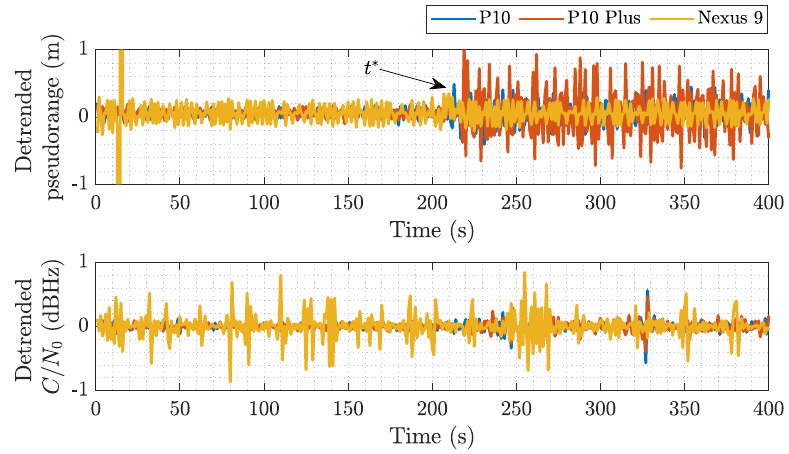
Figure 13. PRN 23 (closest) measurements in the controlled environment, highlighting the change around t ∗ = 210